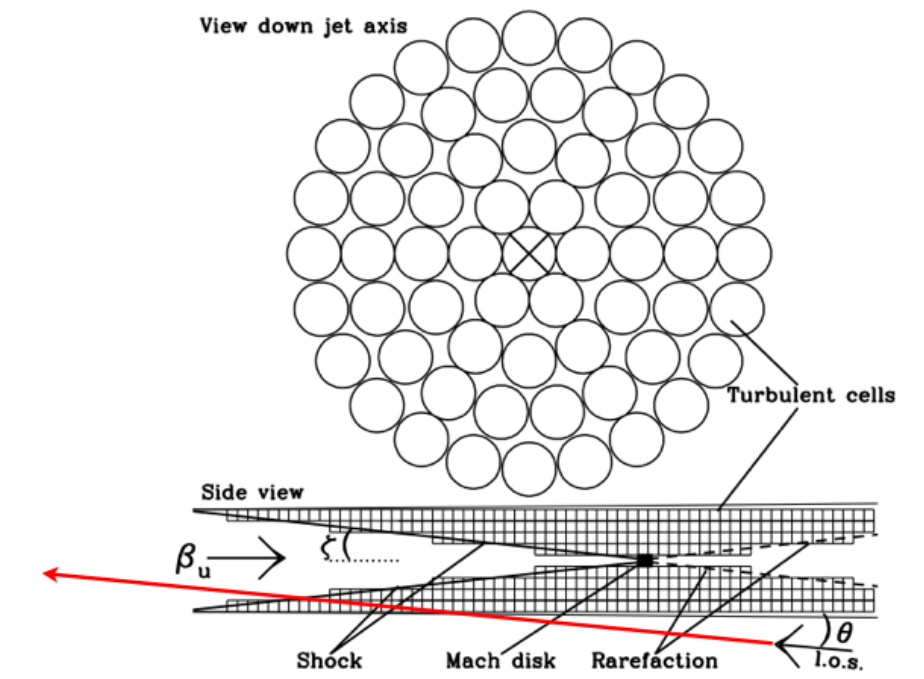
Figure 1. A depiction of the turbulent extreme multi-zone (TEMZ) model—reproduced by permission from [3]. The emission from the radio core of a blazar is modeled as the aggregate emission emanating from thousands of turbulent cells of plasma moving relativistically across a conical shock. The red line illustrates that along a given line-of-sight through the TEMZ model, a ray will cross multiple cells of plasma with varying magnetic field